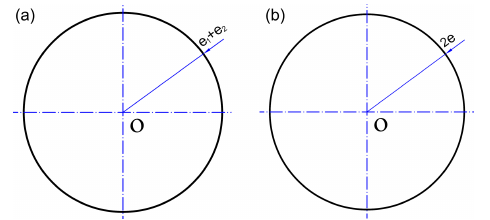
Figure 4. Motion curve of O 2 when ω 1 = ω 2 . (a) e 1 (cid:54)= e 2 , (b) e 1 = e 2 = e .